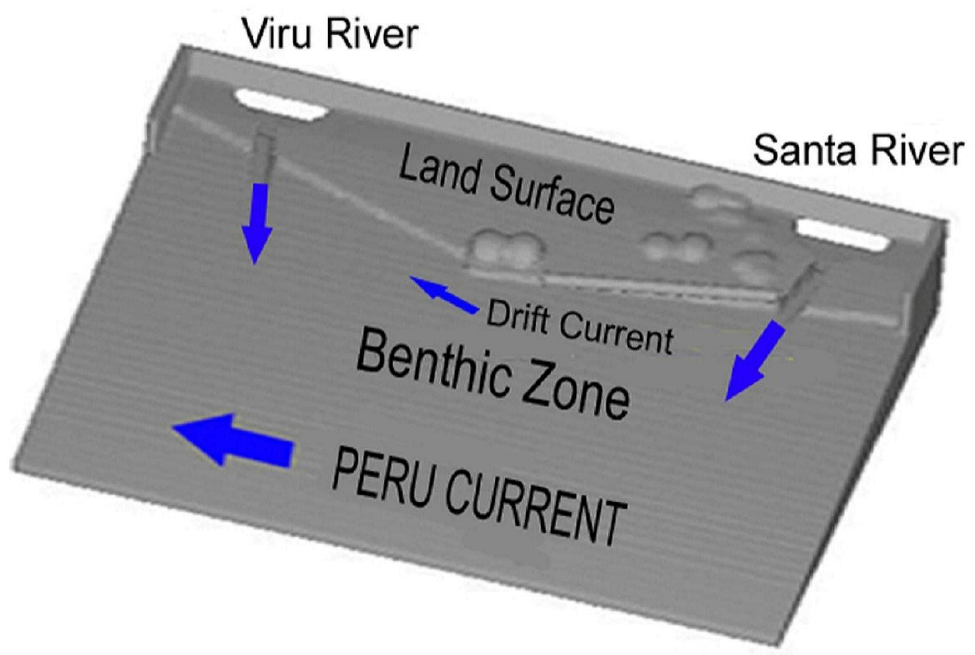
Figure 21. FLOW-3D CFD model of the Peruvian coastline from the Santa to Viru Rivers. The Benthic Zone is the Pacific Ocean; the arrows originating from the Santa and Viru River Valleys represent El Niño flood sediment transfer paths into the Pacific Ocean and offshore arrows denote the direction of the northward Peru Current and the shoreline drift current.